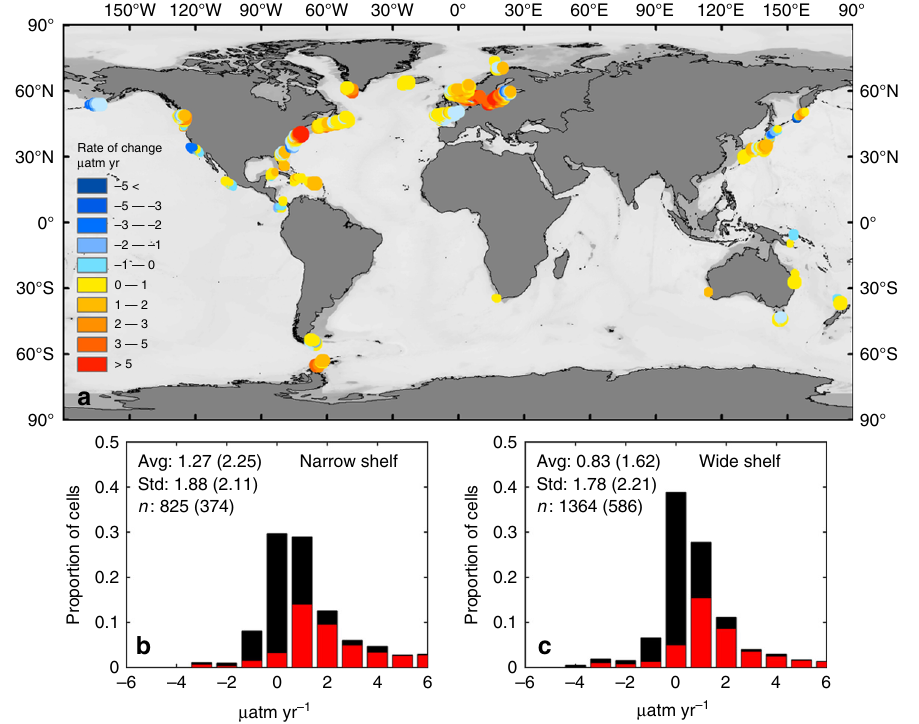
Fig. 2 Location of 0.5° cells for which the decadal trend in winter Δ p CO 2 is calculated ( a ). Large dots correspond to cells shallower than 200 m and small dots correspond to cells located within 100 km from the coast or depth less than 500 m. The distribution of d( Δ p CO 2 ) / d t for both our narrow ( b ) and wide ( c ) de fi nitions of the continental shelf are displayed as histograms. The black bars report the distribution of all cells while the red bars report the distribution of cells for which the trend was deemed statistically signi fi cant using an F -test with p < 0.05. Here, Δ p CO 2 = p CO 2,air — p CO 2 . Thus, positive values in d( Δ p CO 2 ) / d t indicate slower increase in water p CO 2 than p CO